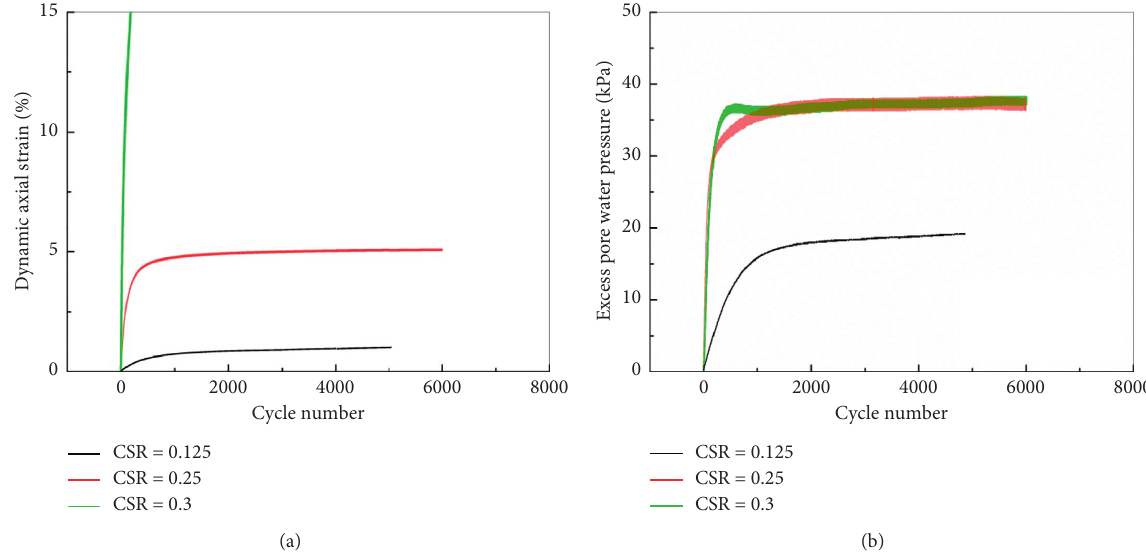
Figure 3: Dynamic response of soil specimen at different CSR: (a) dynamic axial strain; (b) excess pore water